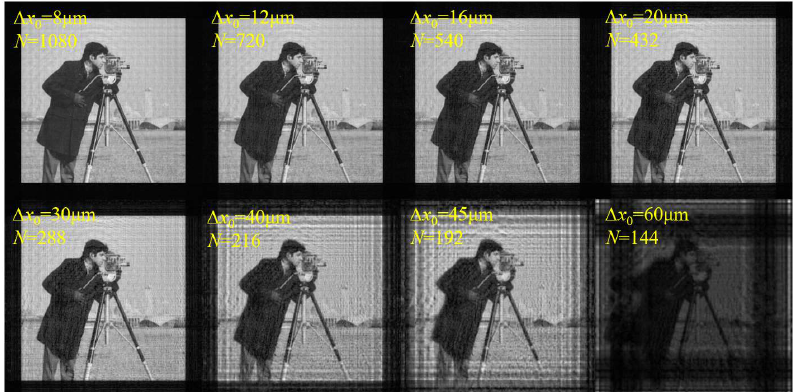
Figure 6. Calculated amplitude distributions on the diffraction plane with different ∆ x 0 and N using SASM. using